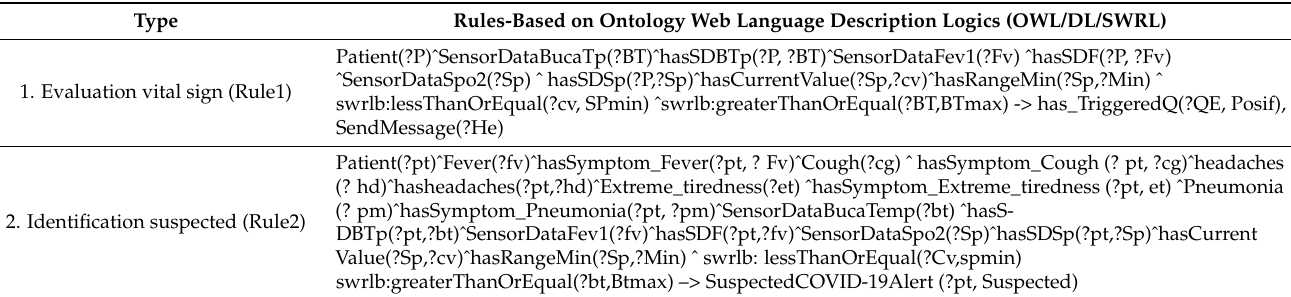
Table 4. Detection of suspected patient’s